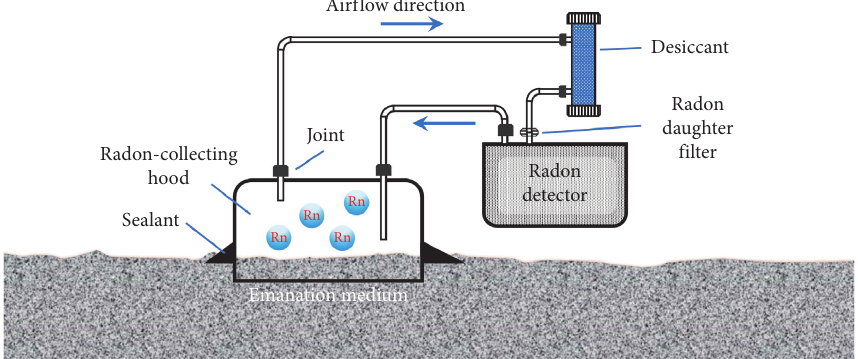
Figure 2: Principle diagram of radon exhalation rate measurement. The radon is collected by RAD-7 after being dried by a desiccant and filtered by a radon daughter